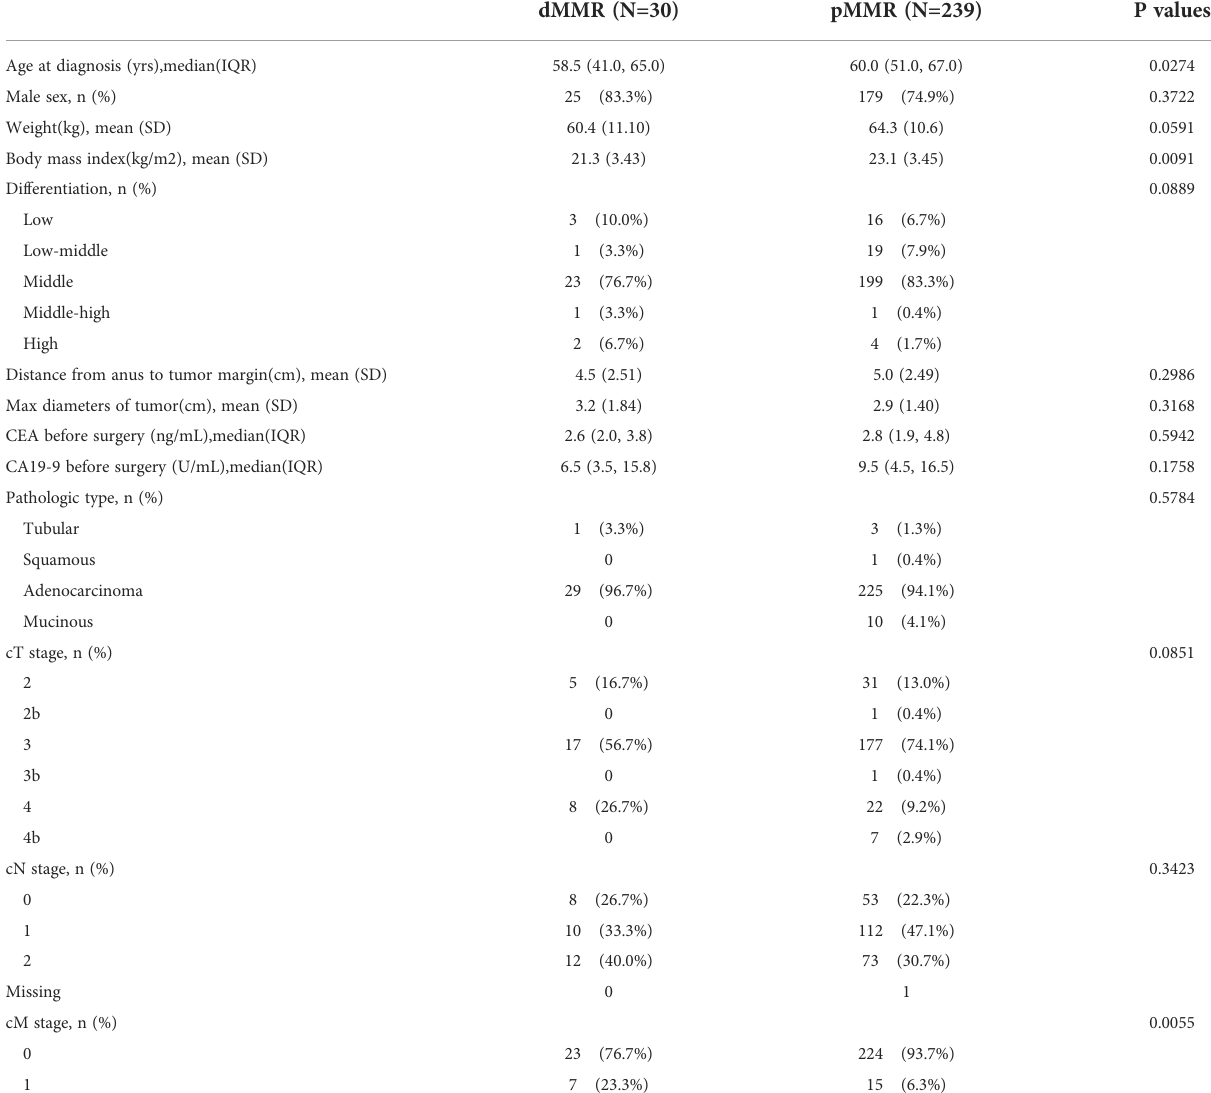
TABLE 1 Clinical characteristics of 269 MMR